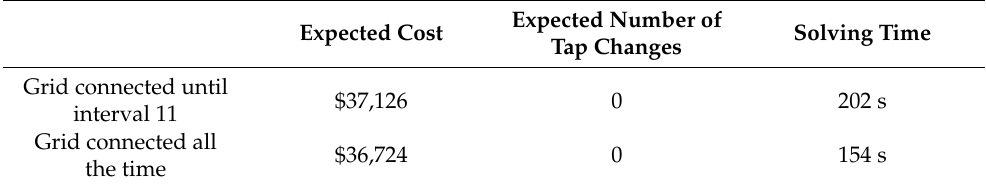
Table 2. Results of two different grid-connection